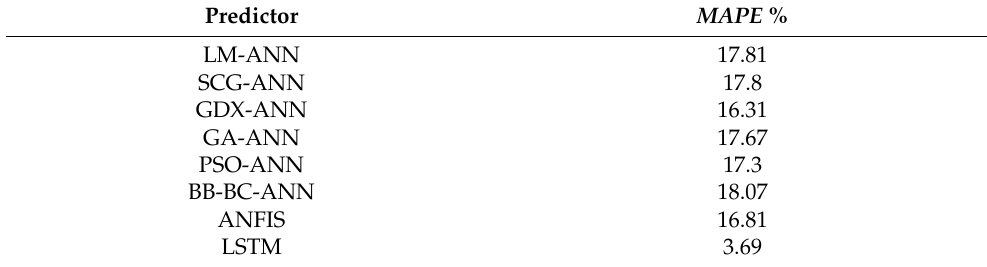
Table 7. MAPE results for June